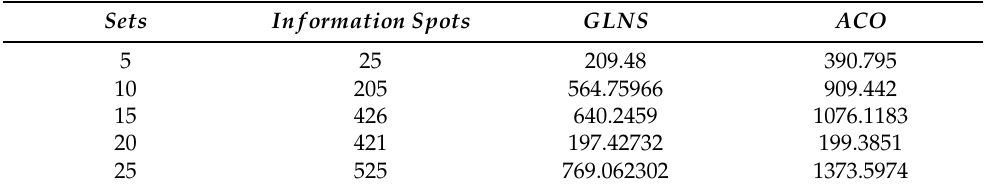
Table 3. The distances of GLNS and ACO paths. On average, the paths of ACO were 1.6587 times the weighted lengths of those of